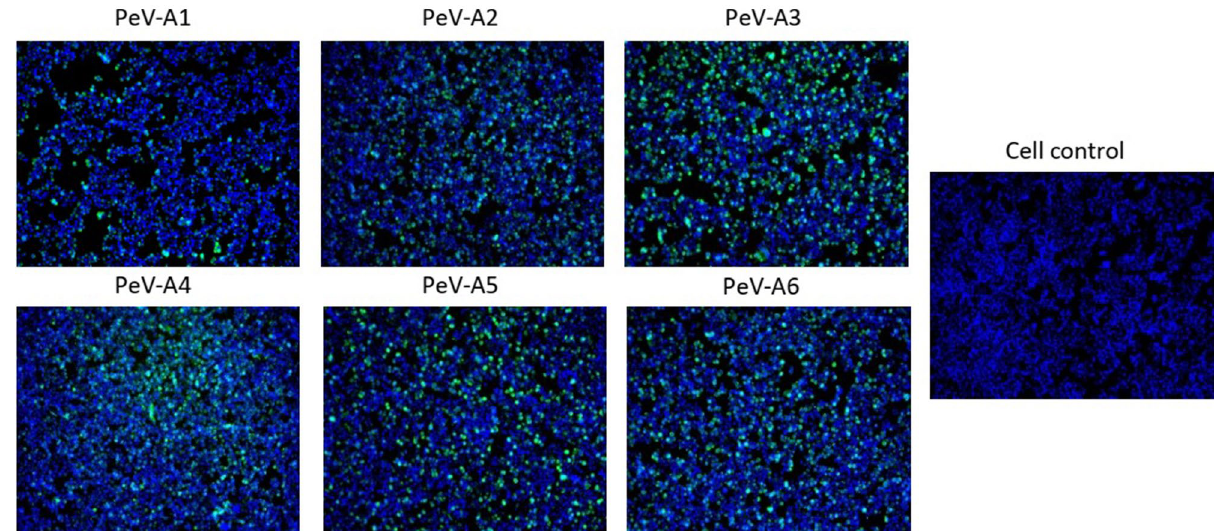
Figure 4. Detection of PeV types 1 to 6 using scFv-71 in IFA. HT-29 cells were mock-infected or infected with PeV types 1 to 6 and stained with scFv-71 antibody followed by staining with rabbit anti-FLAG antibody and anti-rabbit Alexa Fluor 488 secondary antibody. Nuclei were stained with DAPI. Stained cells were visualized using EVOS FL Auto imaging microscope (10 × magnification). Virus strains used in the panel: PeV-A1 “Harris”, PeV-A2 “Williamson”, PeV-A3 “152037”, PeV-A4 “K2511776”, PeV-A5 “20552322” and PeV-A6 “89”.